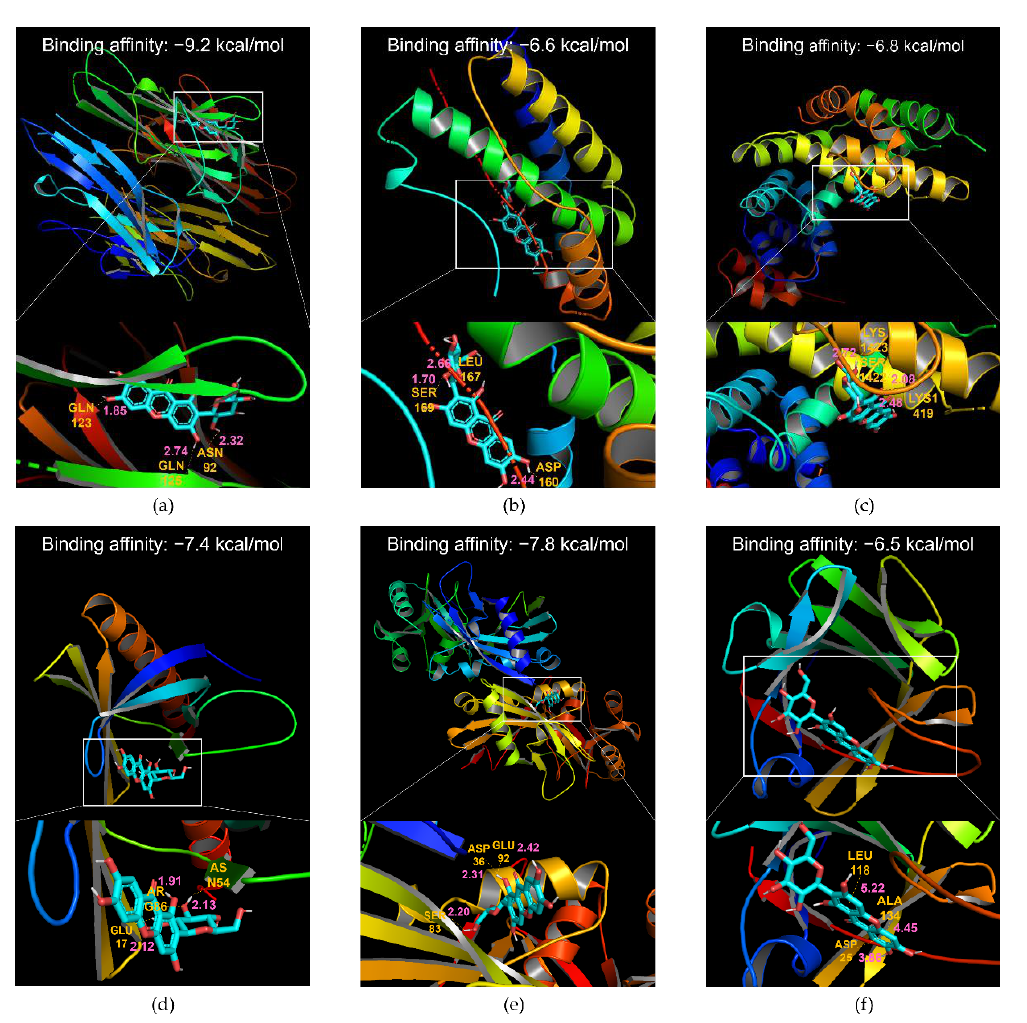
Figure 2. Molecular docking between the MGF and target proteins. ( a ) MGF and TNF- α . ( b ) MGF and IL-6. ( c ) MGF and NF- κ B. ( d ) MGF and AKT1. ( e ) MGF and ATG7. ( f ) MGF and FGF21. Binding energies are expressed on the middle top section of each sub-panel. The top three shortest interaction distances are displayed in pink, and the interacting amino acids are shown in yellow. MGF, mangiferin; TNF- α , tumor necrosis factor- α ; IL-6, interleukin-6; NF- κ B, nuclear factor kappa B; ATG7, autophagy-related gene 7; FGF21, fibroblast growth factor 21.